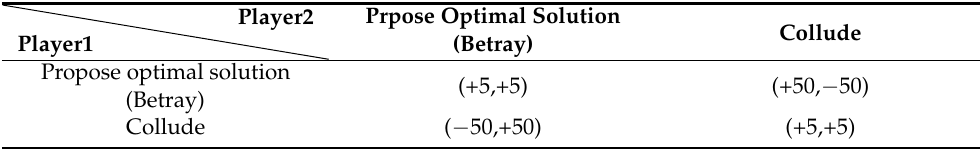
Table 5. The gain for each player according to their played strategy.